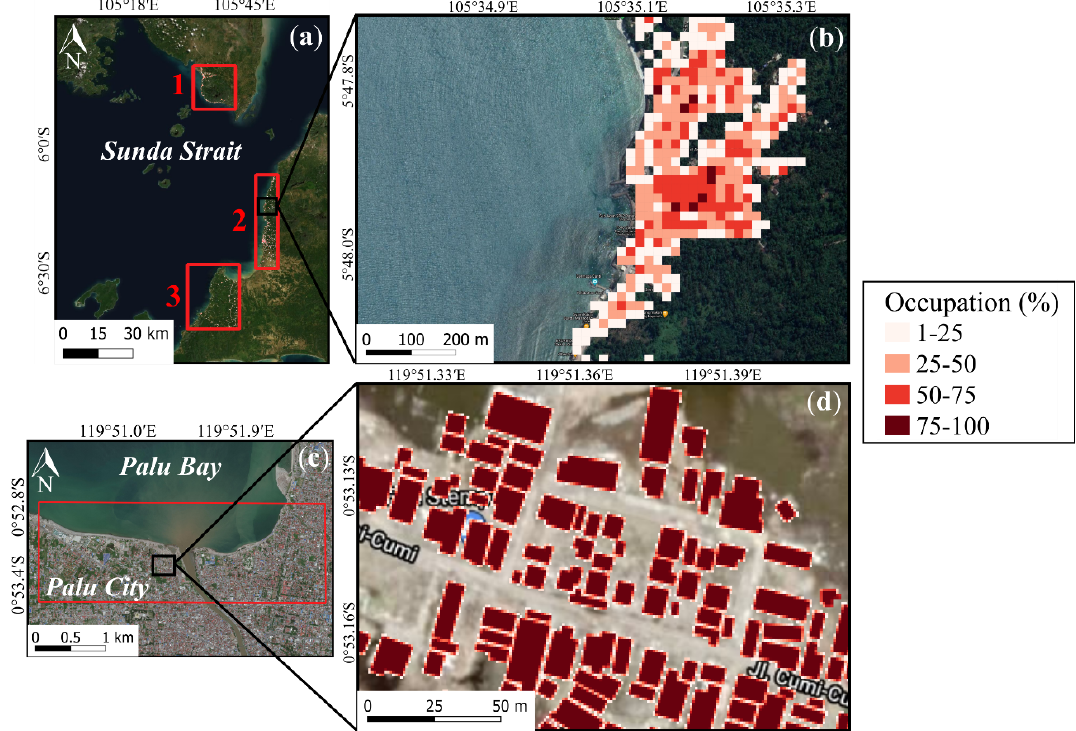
Figure 2. (a and c) Computational areas in the Sunda Strait (1–3) and Palu City, and (b and d) magnified view of the building occupation ratio in Sunda Strait (20m resolution) and Palu City (1m resolution) (background ESRI and © Google